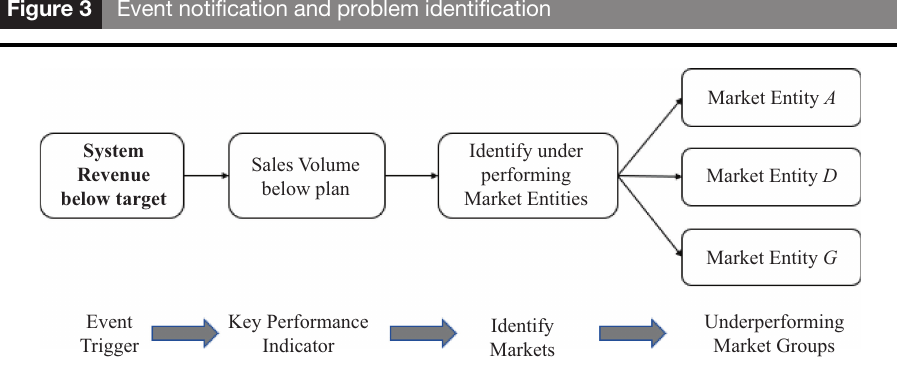
Figure 3 Event notification and problem